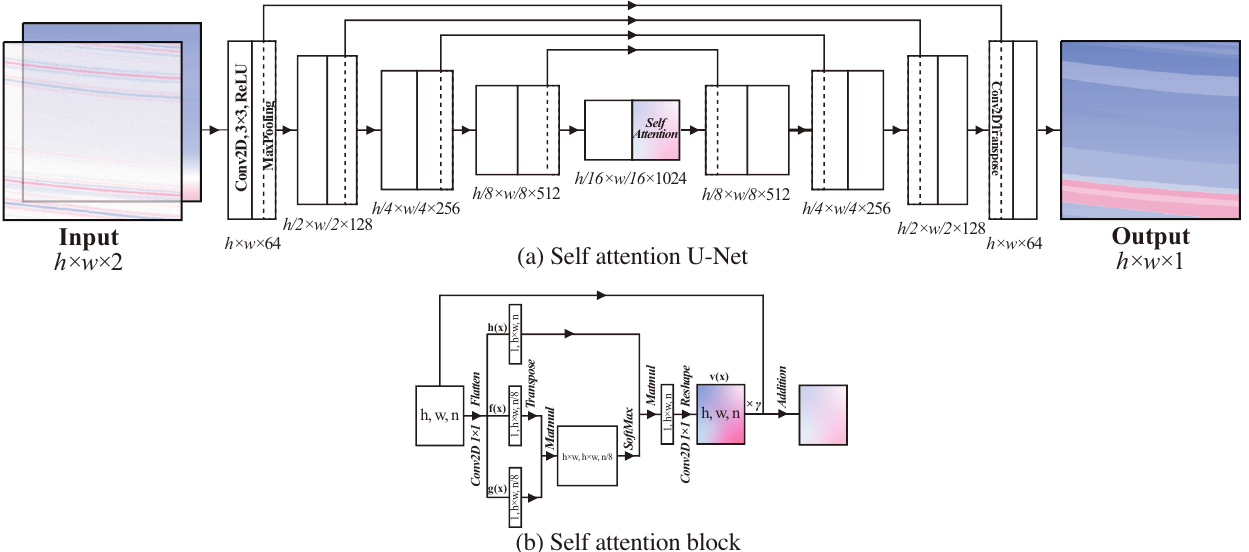
Figure 2. Neural network architecture, ( a ) self-attention U-Net, ( b ) self-attention block. The input data with two channels (first for seismic imaging profile, second for background impedance profile) will be convoluted by four layers. Each layer has double 3 × 3 kernels, the following activation function ReLU, and a max-pooling operation. The height and width would be cut in half, but the number of channels would be double after being convoluted by each layer. Before transpose convolution, the data is processed by a self-attention block, which is shown in ( b ). It gave a weighted metric to the feature map. To recover features from the high-dimension maps, there are four corresponding transposed convolutional layers. Each layer has a shortcut to concatenate features with different receptive fields. After that, the shape of the output would be the same as the